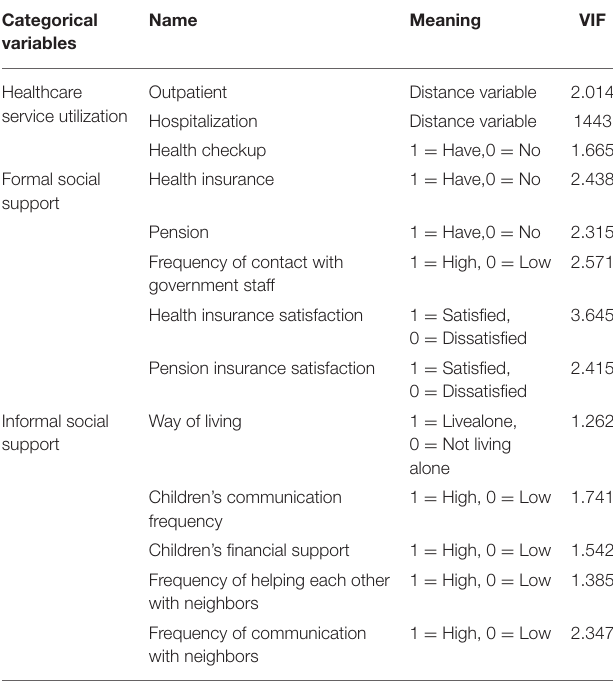
TABLE 2 | Influencing factors of mental health of older